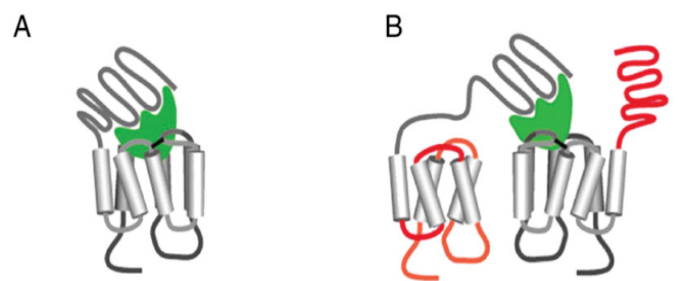
Figure 4. Schematic representation of cis-activation ( A ) and trans-activation ( B ) of a glycoprotein hormone receptor. Cis-activation occurs when hormone bound to the LHRs or FSHRs extracellular domain interacts with the portions of the same receptor involved in signal transduction. Trans-activation occurs when the hormone bound to the extracellular domain on one receptor interacts with an adjoining receptor that then initiates signal transduction. This figure was reprinted from [59] under the terms of the Creative Commons Attribution 4.0 License.